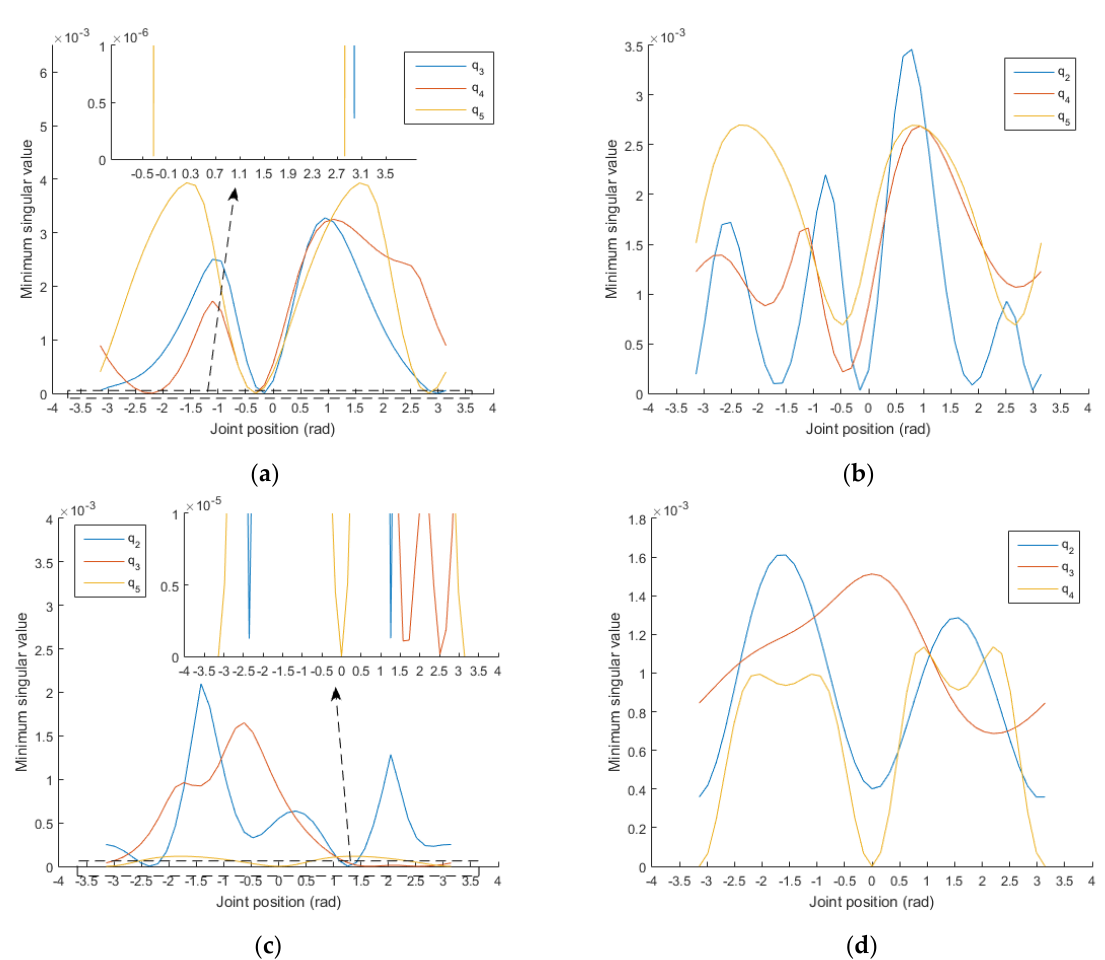
Figure 6. ( a ) The distribution of the minimum singular value with the change in d 1 and ( b ) the distributions of the minimum singular values with the changes in q 6 and q 7 .